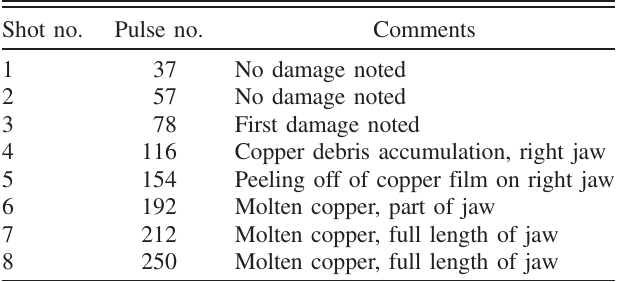
TABLE IV. Summary of observations for each shot in the experiment.